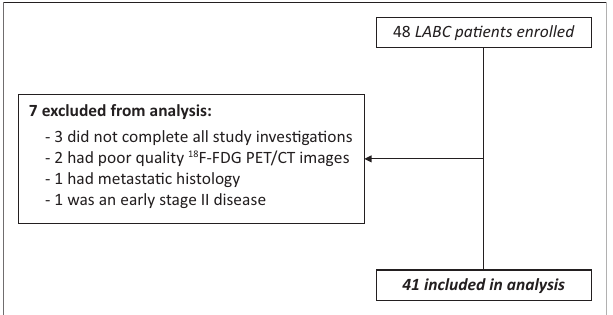
FIGURE 1: Study subject recruitment and inclusion for analysis. TABLE 1: Demographic and clinical characteristics of participants ( N = 41).